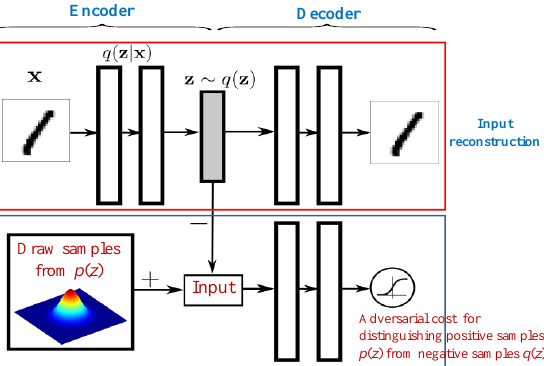
Figure 3. The architecture of an AAE [13]. The red rectangle is a standard AE with an encoder and decoder to reconstruct an image x from a latent code z . The encoder of the AE q ( z | x ) is also a generator of the adversarial network. The blue rectangle describes the discriminative network, which is used to predict whether a sample arises from the hidden code of the AE or from a sampled distribution p ( z ).